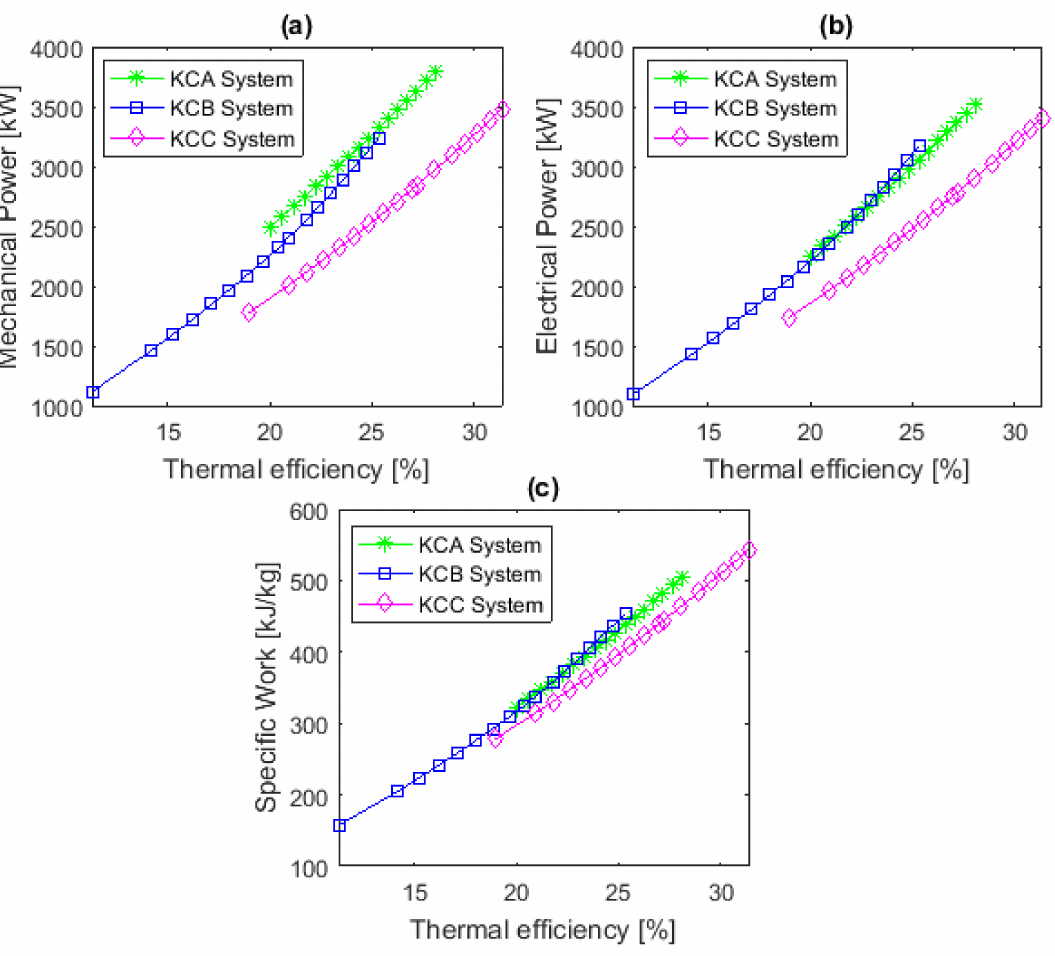
Figure 6. Influence of thermal efficiency (under the effect of inlet temperature of HPT) on the: ( a ) mechanical power, ( b ) electrical power, ( c ) specific